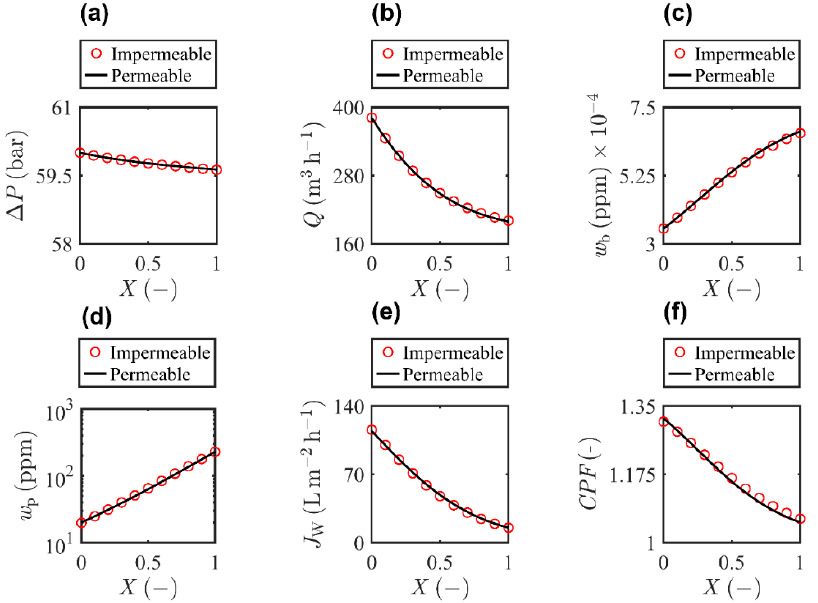
Figure 10. The simulated results at the system level using the impermeable and permeable wall models with the feed salinity ( w b, 0 = 35,000 ppm), water recovery ( R r, 0 = 50%), pump efficiency (0.85), energy recovery device efficiency (0.95) and water permeability ( L p = 5 L m − 2 h − 1 bar − 1 ). ( a ) Transmembrane pressure, ∆ P (bar), ( b ) Flow rate, Q (m 3 h − 1 ), ( c ) Brine salinity, w b (ppm), ( d ) Per- meate salinity, w p (ppm), ( e ) Permeation flux of water, J W (L m − 2 h − 1 ), ( f ) CP factor, CPF ( − ) along the dimensionless length ( X ).